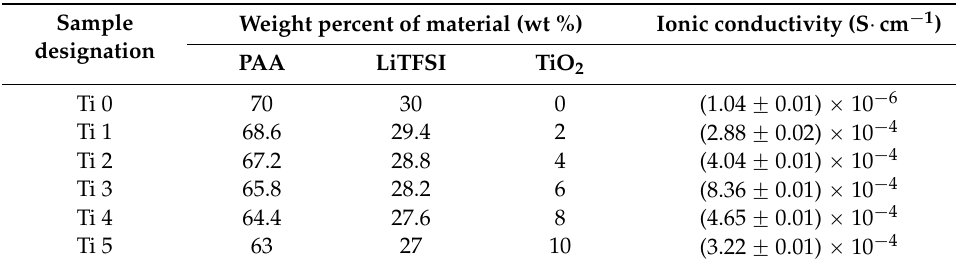
Table 1. The composition of each material used in the polymer electrolyte membrane preparation, the designation of the polymer electrolyte membranes and the ionic conductivity of the polymer electrolyte